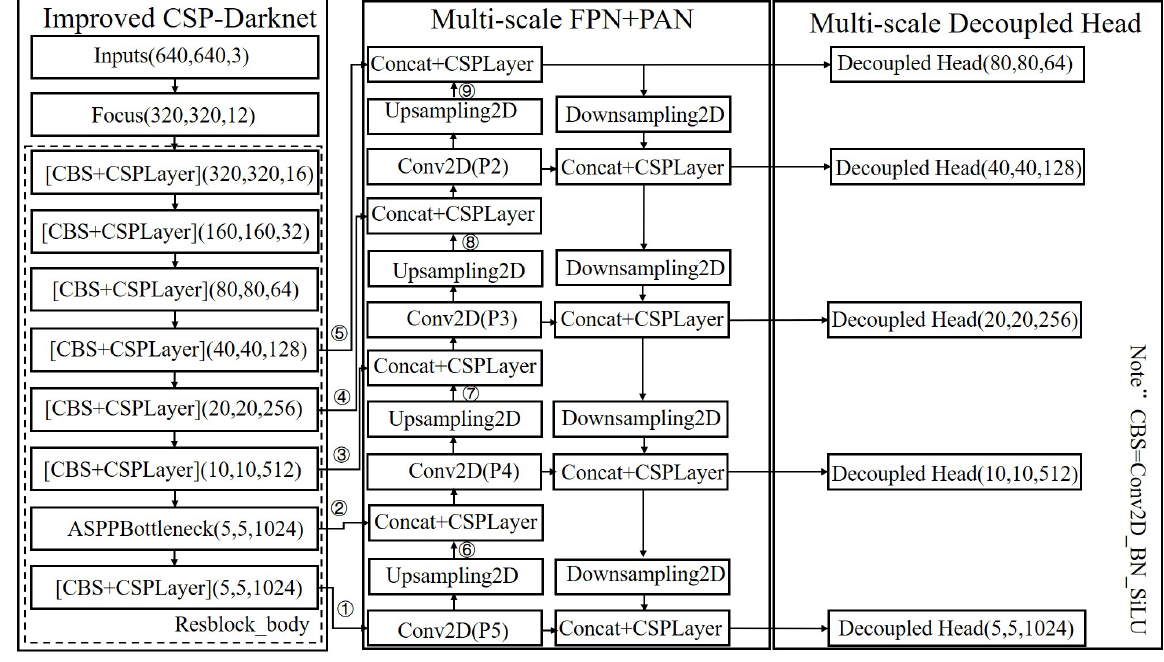
Fig. 7. The network structure of improved YOLOX.